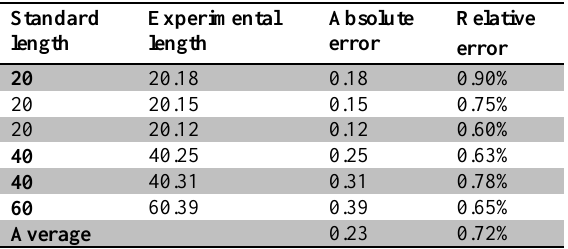
Table 3 Segment measurement results obtained by Ref. 21’s method (mm).